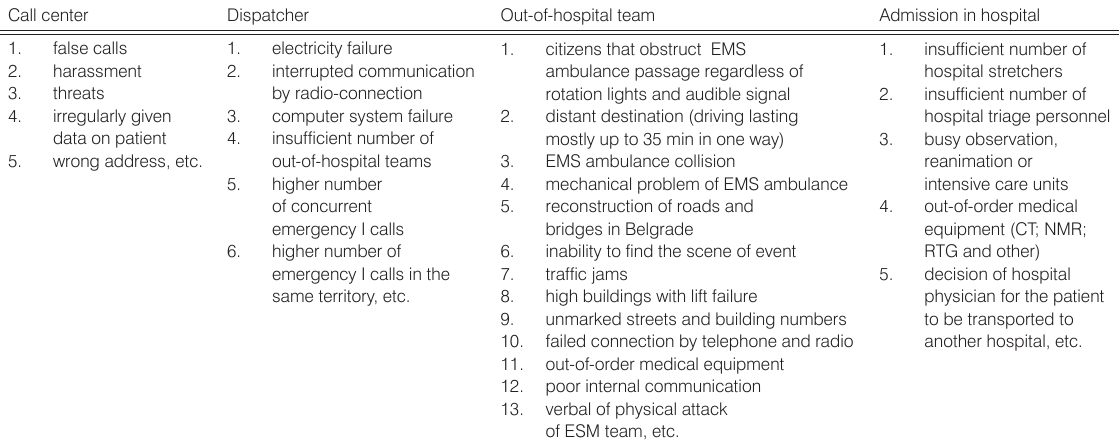
Table 2. Possible problems in the work of Belgrade